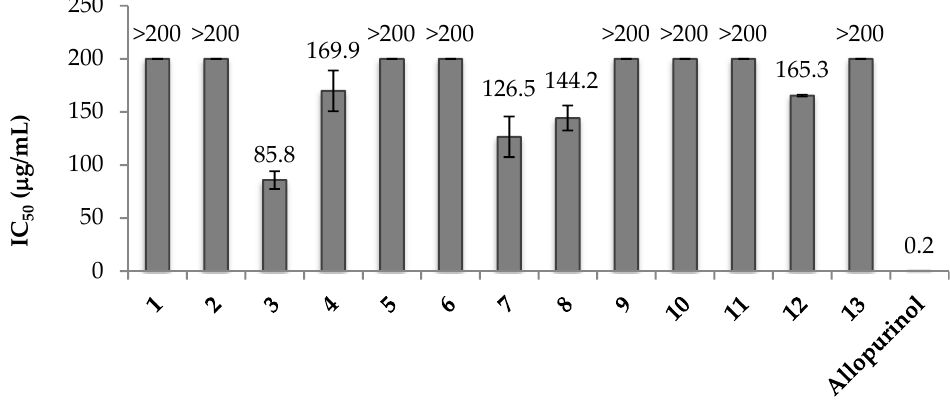
Figure 2. Xantine oxidase inhibitory activity of synthesized compounds 1 – 13 . Allopurinol served as the reference compound. Bars are mean ± SD, n = 3.